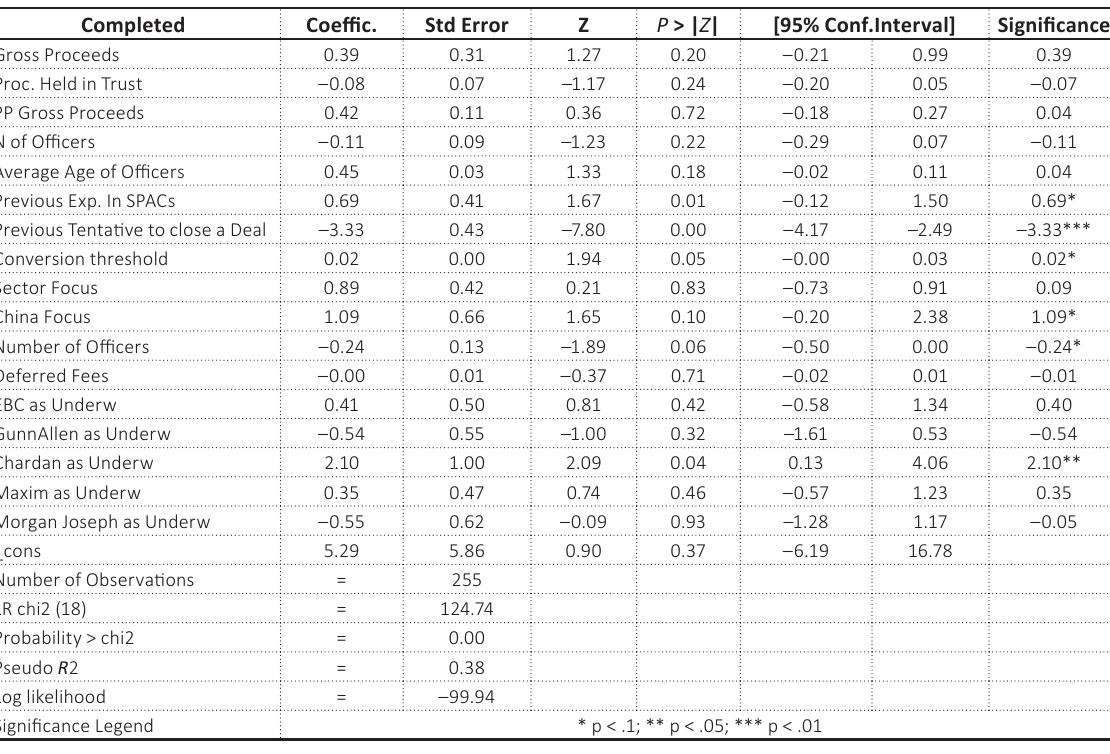
Table 5. Regression